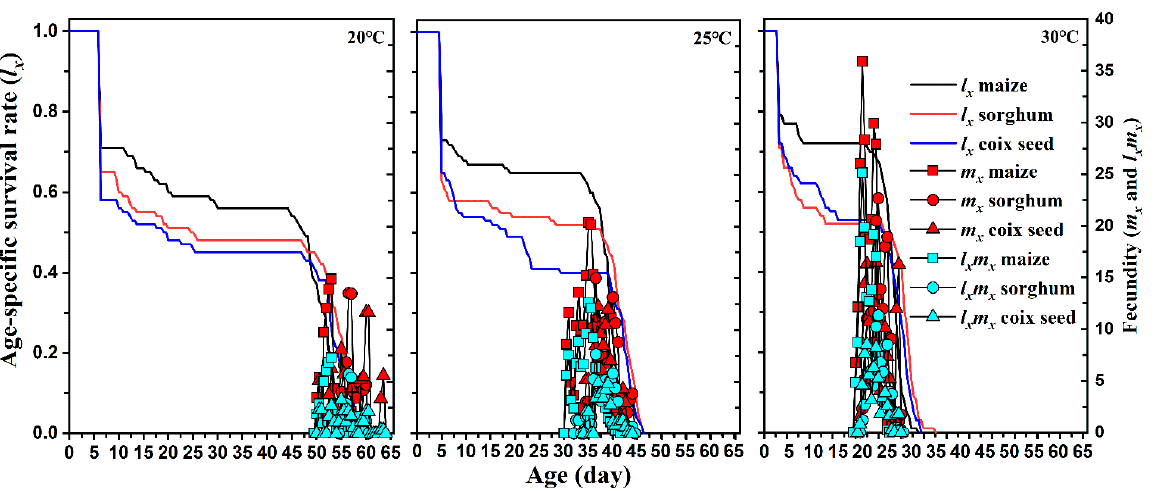
The lowercase letters (a–c) indicate significant differences in the developmental duration of Spodoptera frugiperda on different hosts at the same temperature. The capital letters (A–C) indicate significant differences in the developmental duration of S. frugiperda at different temperatures on the same host. A paired bootstrap test was used to detect statistical differences in the mortality at different stages of S. frugiperda on different host plants or different temperatures. Standard errors were estimated using 100,000 bootstrap resampling.